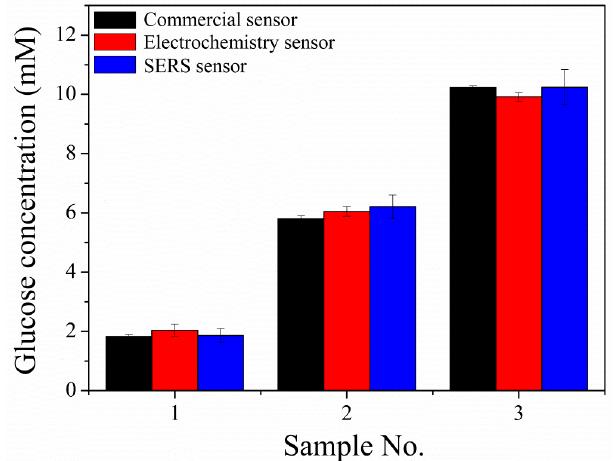
Figure 5. Determination of glucose at different concentrations in alkalized human serum samples with a commercial sensor, electrochemical sensor, and Surface Enhanced Raman Scattering (SERS).